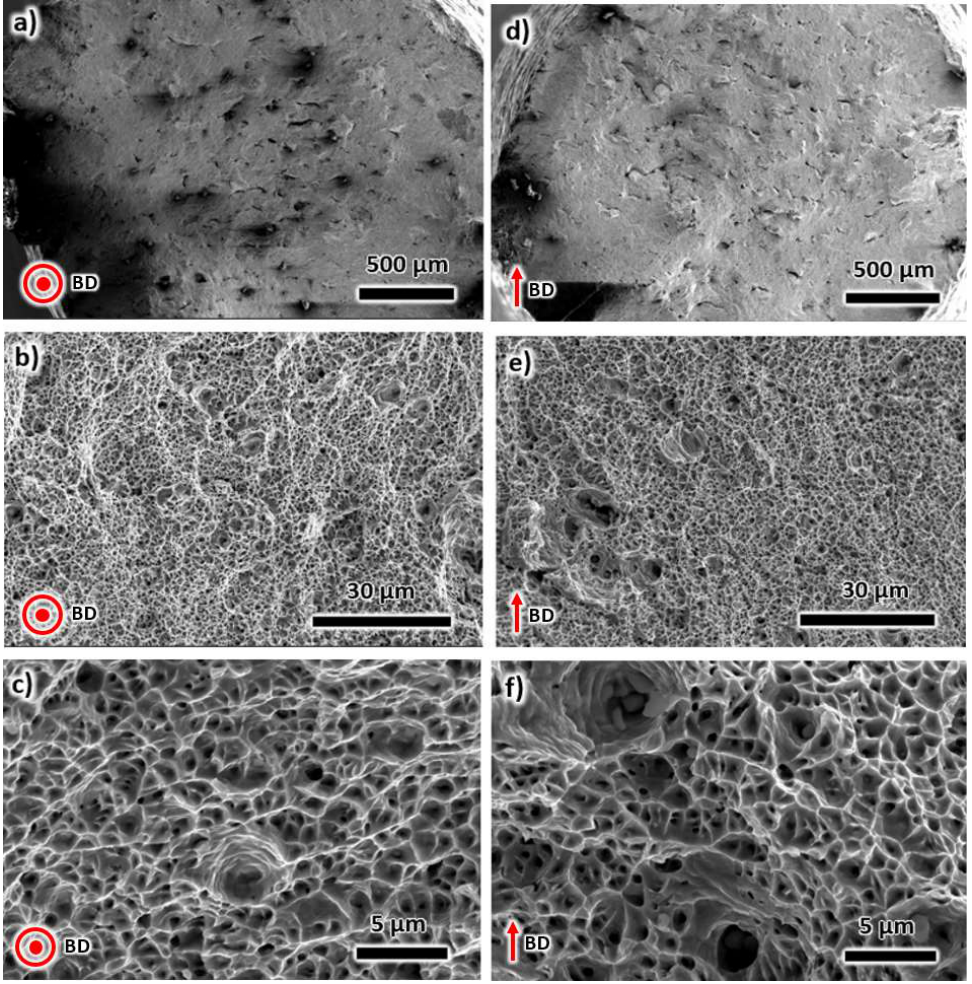
Figure 12. SEM images of the hot isostatic pressed and annealing heat-treated sample tensile tested along the BD ( a – c ) and the TD ( d – f ).